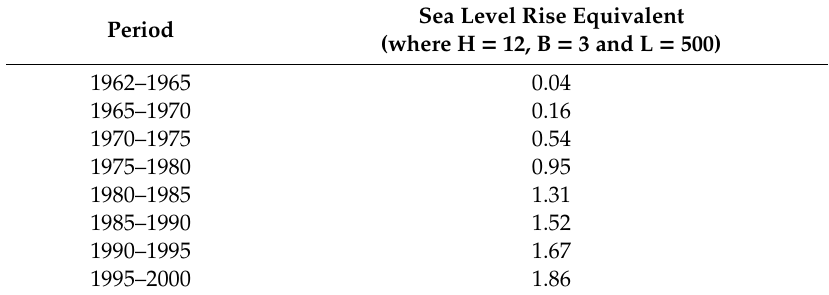
Table 5. Sea level rise equivalent of recession of Southern Gold Coast Beaches due to sand trapped by extended Tweed River training walls, 1960–2000.